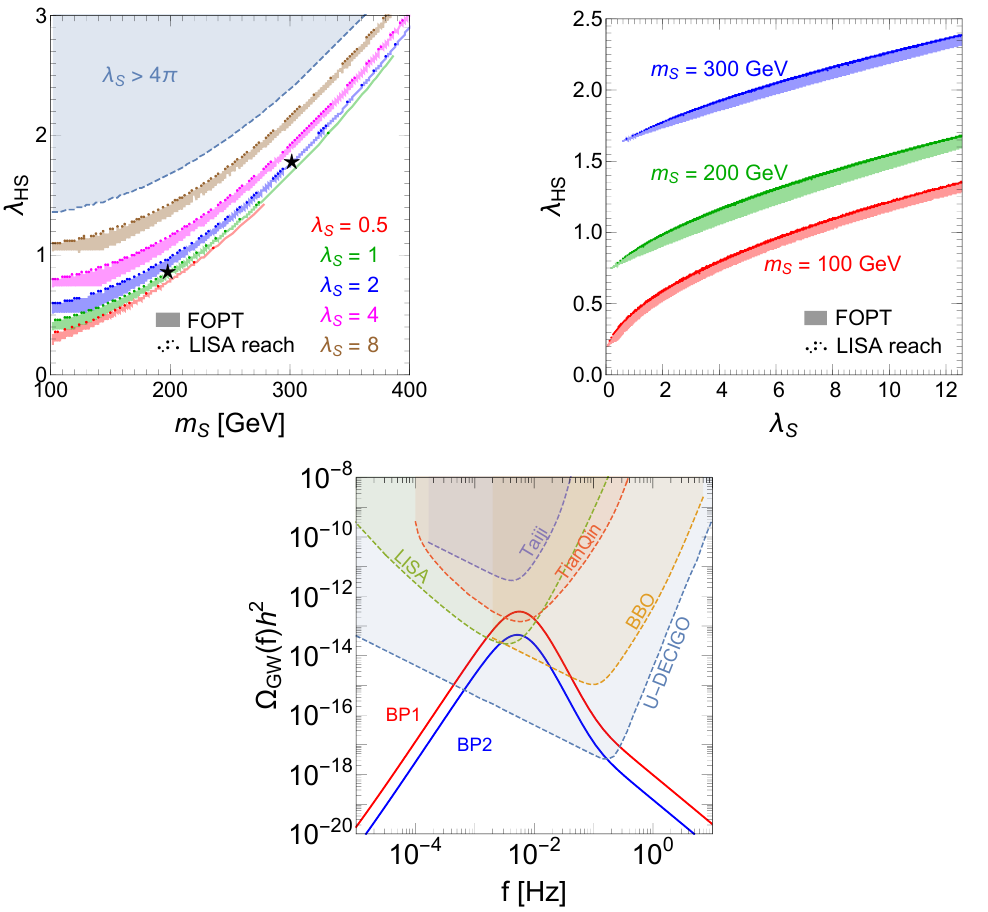
Figure 13 . Top: the parameter space that triggers FOPT and can be probed by LISA, projected to different 2-dimension planes. Bottom: the GW spectrum from two benchmark points which are labeled as stars in the top left